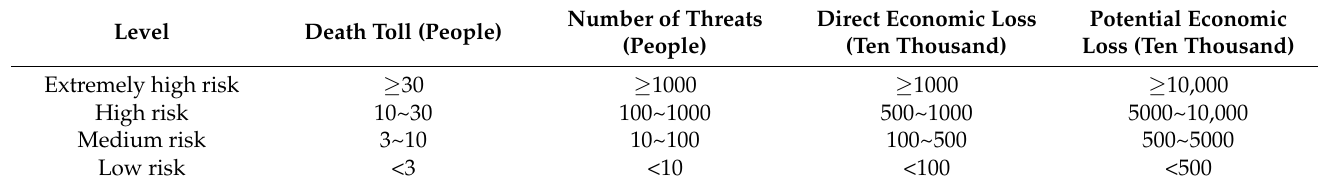
Table 2. Classification standards of geological